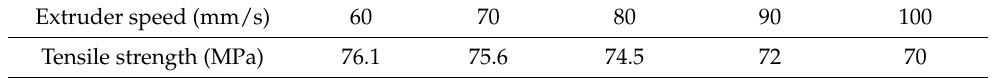
Table 5. Tensile strength vs. extruder speed.